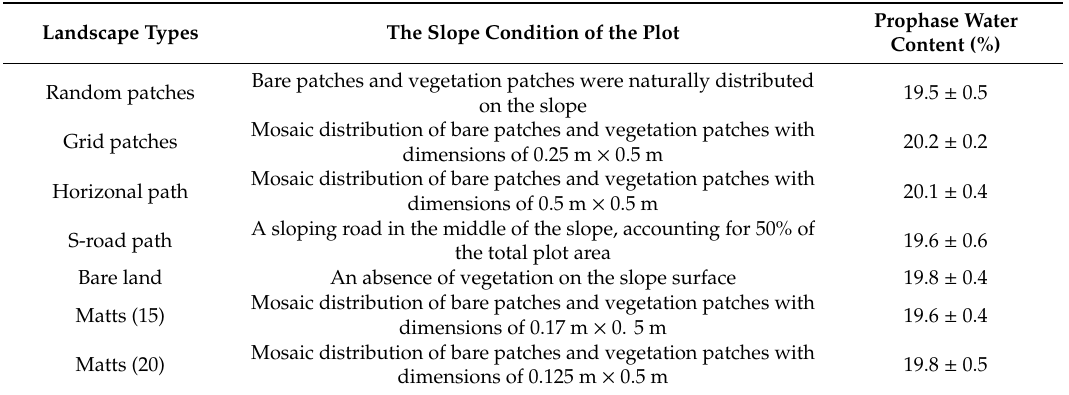
Figure 2. Field experiment blueprints of different types of patches and different number of patches under the same coverage. Table 2. Basic overview of the runoff plots.